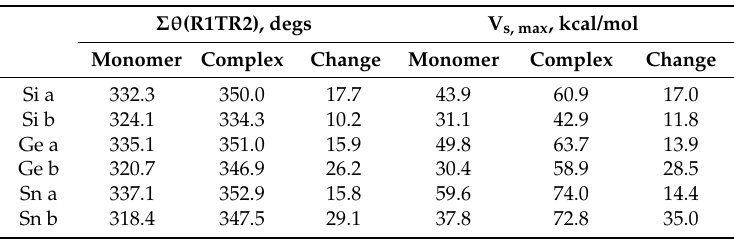
Table 4. Planarity measure and MEP maximum of TH 2 F 2 molecule in its geometry within the monomer and within its complex with NH